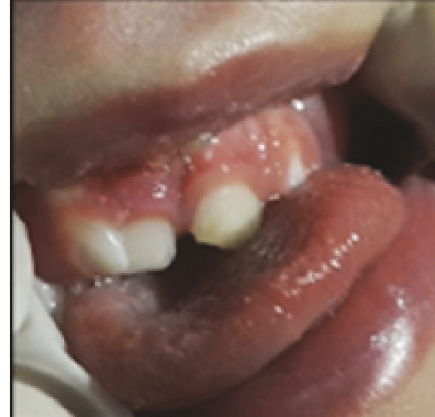
Figure 2: At the examination six months later, erupted 51, 52, and 62 numbered teeth, and the fusion between 51 and 52 numbered teeth, and the enamel fracture at the mesial edge of 61 numbered tooth.